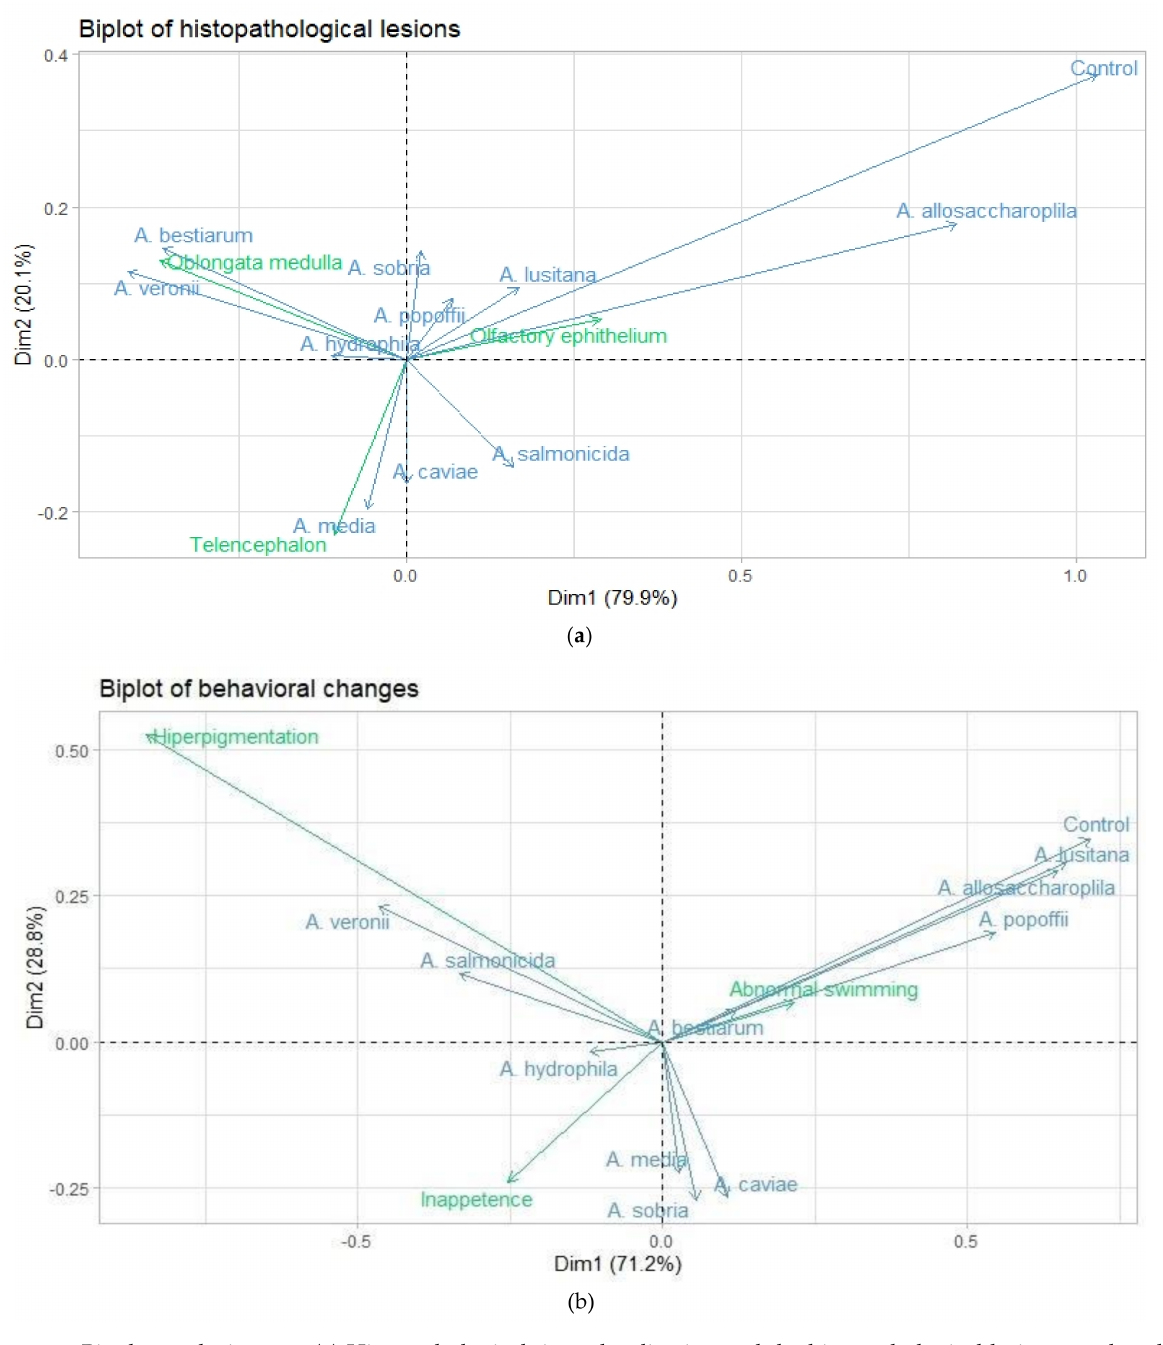
Figure 3. Bioplot analysis map. ( a ) Histopathological tissue localization and the histopathological lesions produce by different Aeromonas species in rainbow trout fingerlings of representation to row and columns of dimension 1; ( b ) behavioral changes observed in fingerlings experimentally infected with different Aeromonas species and quality of representation to row and columns of dimension